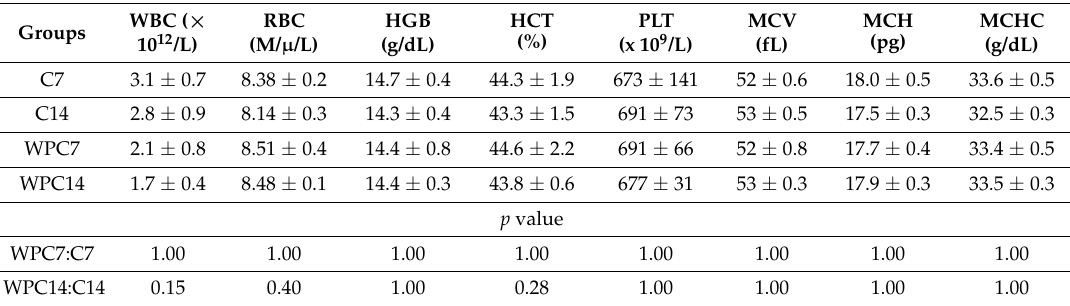
Table 3. Morphological parameters of rats from control and experimental groups. Abbreviations: C7, C14, control groups; WPC7, WPC14, experimental groups treated WPC-80; HCT, hematocrit; HGB, hemoglobin; MCV, mean corpuscular volume; MCH, mean corpuscular hemaglobin; MCHC, mean corpuscular hemoglobin concentration; RBC, erythrocytes; PLT, platelets; WBC, leukocytes. Data are presented as mean ± SD. Because the results were normally distributed, a student’s t -test was used to compare differences between the studied